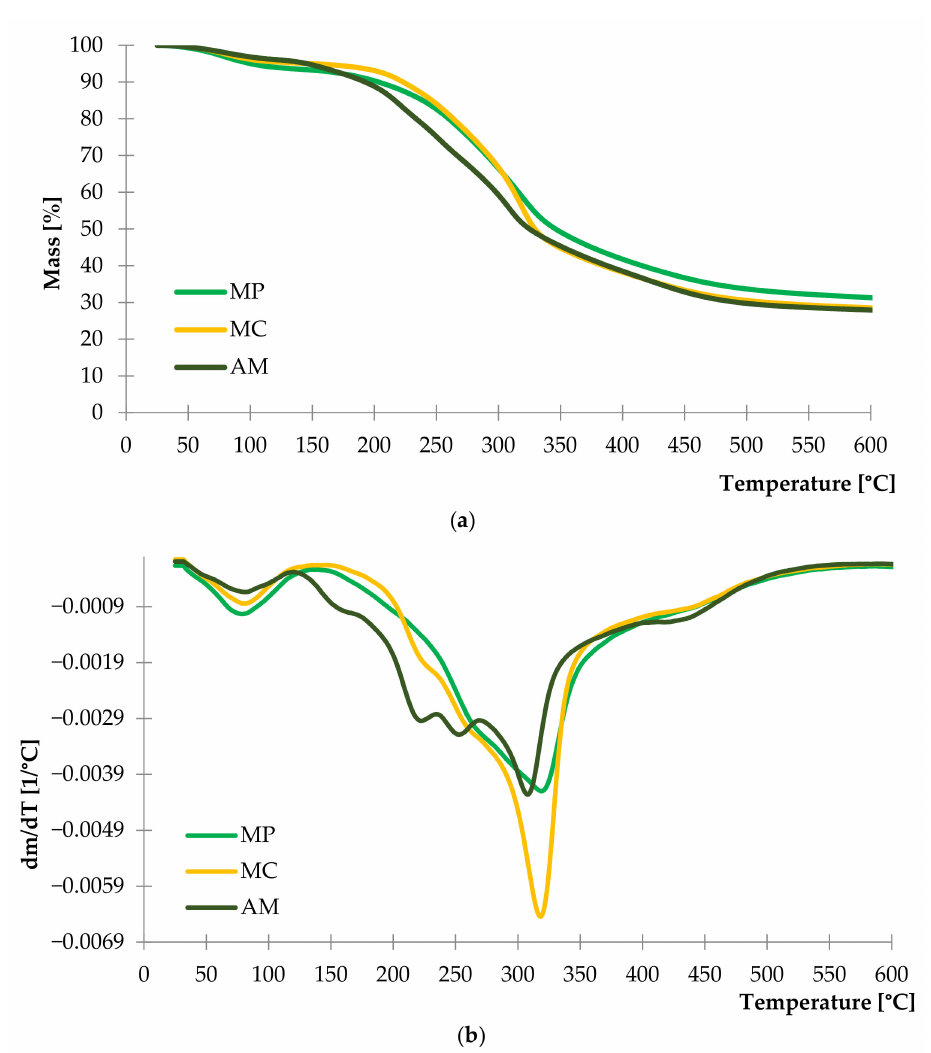
Figure 3. TG ( a ) and DTG ( b ) curves of peppermint (MP), German chamomile (MC) and yarrow